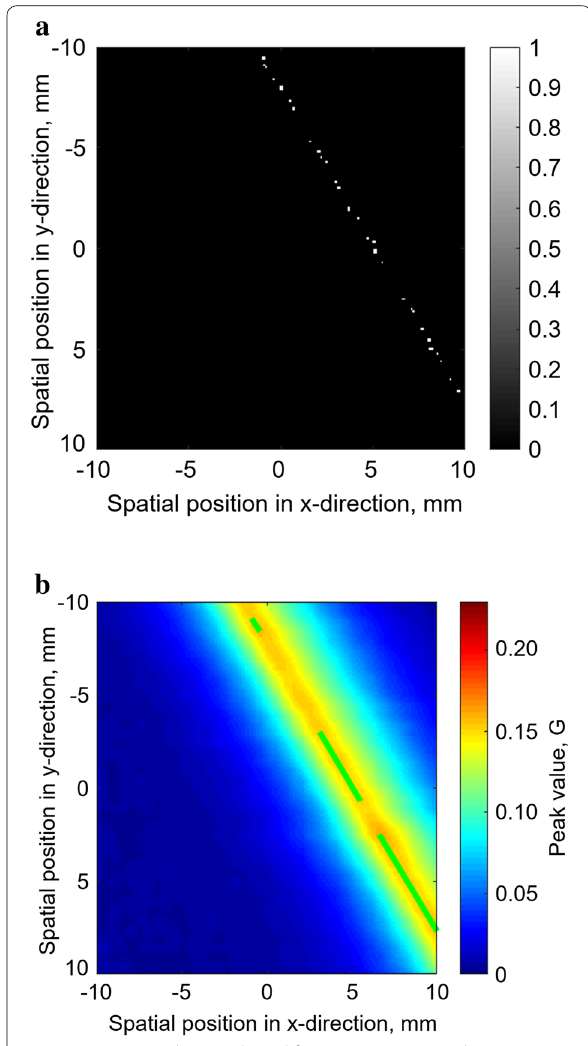
Figure 4 Proposed image-based feature extraction technique on additional scanning of crack of 45º, 4 mm, where ( a ) is the binary image containing crack direction and ( b ) is the detected line